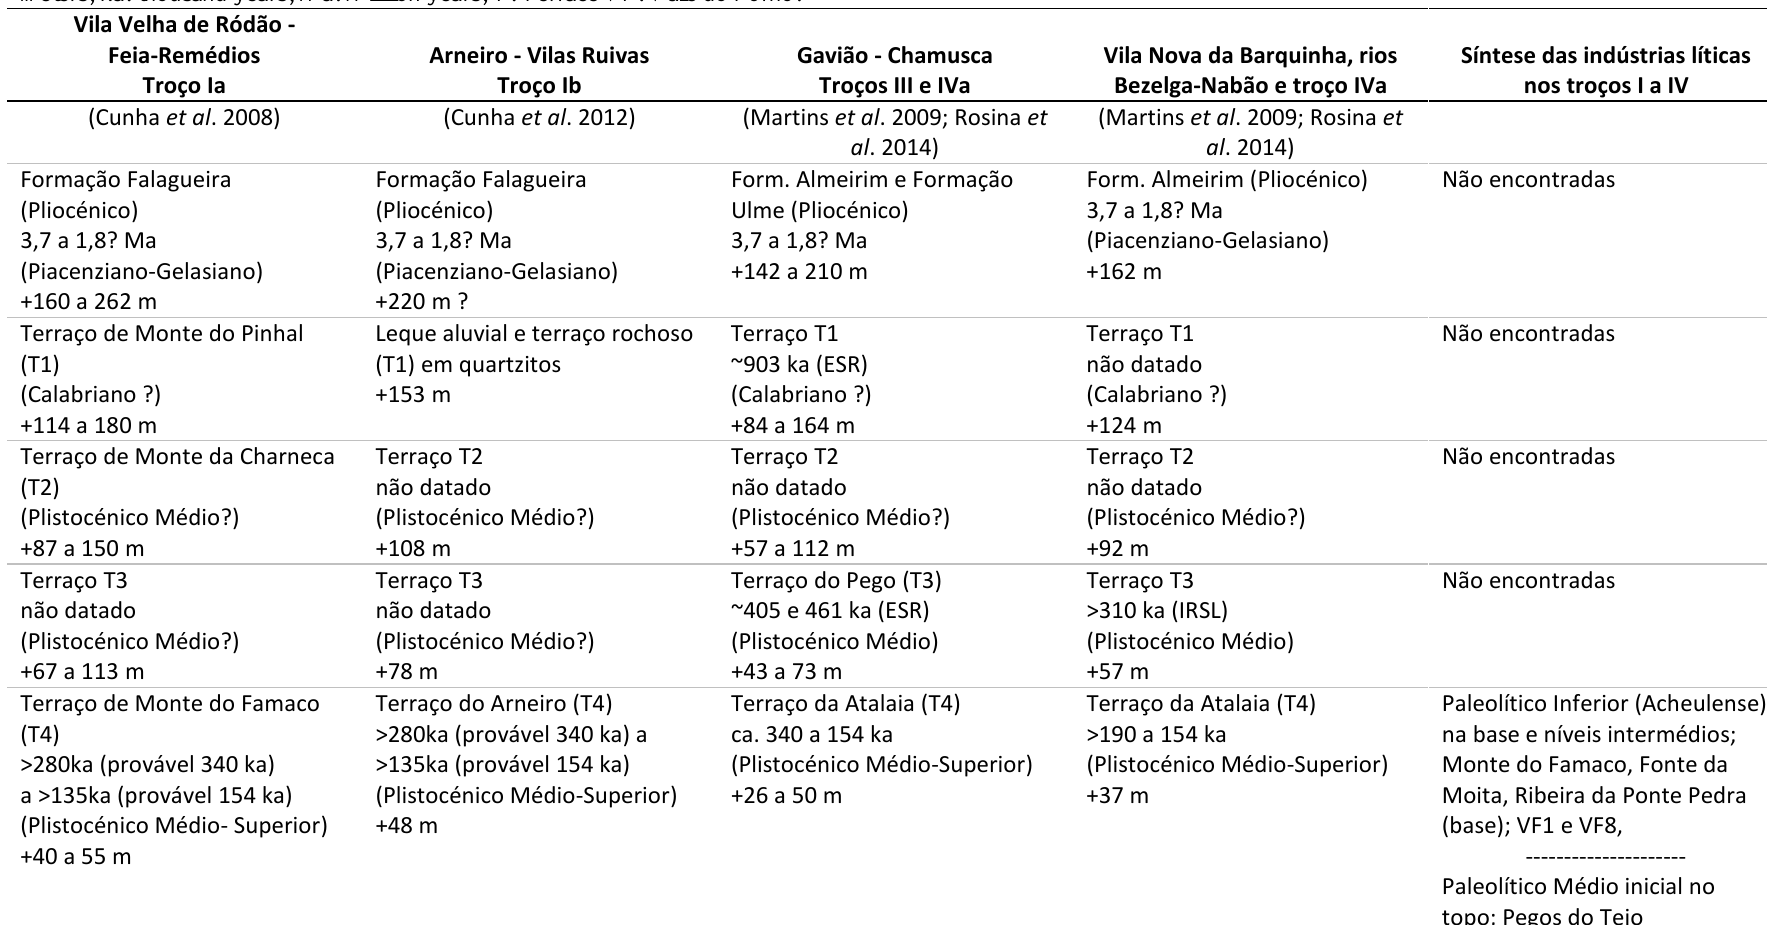
Tabela 1. Síntese dos principais atributos geológicos, geomorfológicos e arqueológicos da unidade sedimentar culminante e das sequências de terraço dos troços I a IVa do sector português do vale do Tejo (Ródão à Chamusca) e de alguns afluentes, com indicação da elevação acima do leito (a.r.b.) e da idade. Abreviaturas: m: metros; ka: Table 1. Summary of key geological, geomorphological and archaeological attributes for the culminant sedimentary unit and terrace sequences represented at the reaches I to IVa of the Lower Tejo River (Ródão to Chamusca) and some tributaries, with indication of the probable age and elevation above river bed of each surface. Abbreviations: m: meters; ka: thousand years; Ma: Million years; T: Terrace VF: Vale do